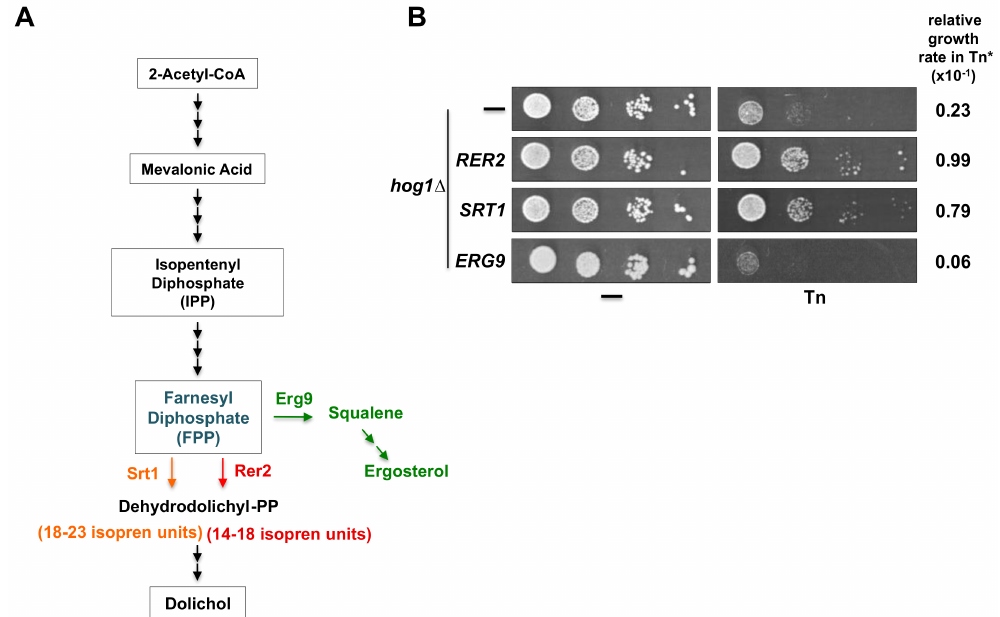
Figure 7. E ff ects of overexpression of proteins involved in the dolichol and ergosterol synthesis pathways on hog1 ∆ Tn sensitivity. ( A ) Schematic representation of the dolichol and ergosterol synthesis pathways. Farnesyl diphosphate (FPP) is synthesized from 2-Acetyl-CoA through the mevalonic acid pathway. FPP is a shared substrate of Rer2 (and Srt1) and Erg9 to synthesize either dolichol or ergosterol respectively. ( B ) Serial dilution assay of the hog1 ∆ strain transformed with the pYES2 vector or with pYES2 carrying RER2 , SRT1 , or ERG9 genes. A spot dilution assay was performed as described above (Figure legend 2B) except that the cells were grown in SRaf medium and then spotted onto SGal or SGal containing 0.5 µ g / mL Tn. Plates were incubated at 30 ◦ C for 72 h and scanned. (*) The growth rate in Tn was measured as described in Figure legend